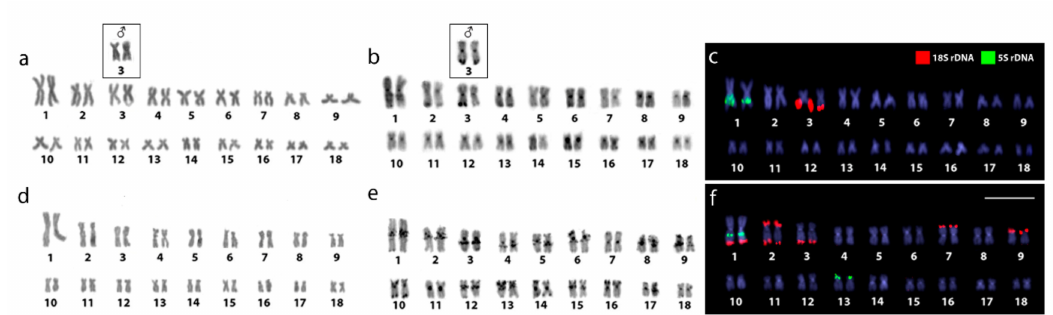
Figure 1. Female karyotypes of Lebiasina bimaculata ( a – c ) and Lebiasina melanoguttata ( d – f ) arranged after di ff erent cytogenetic procedures. Giemsa staining ( a , d ), C-banding ( b , e ), and dual-color fluorescence in situ hybridization (FISH) with 18S (red) and 5S (green) ribosomal DNA probes ( c , f ). Chromosomes were counterstained with 4’,6-diamidino-2-phenylindole (DAPI) in blue. The inserts highlight the homomorphic condition related to pair 3 in the males of L. bimaculata . Scale bar = 5 µ